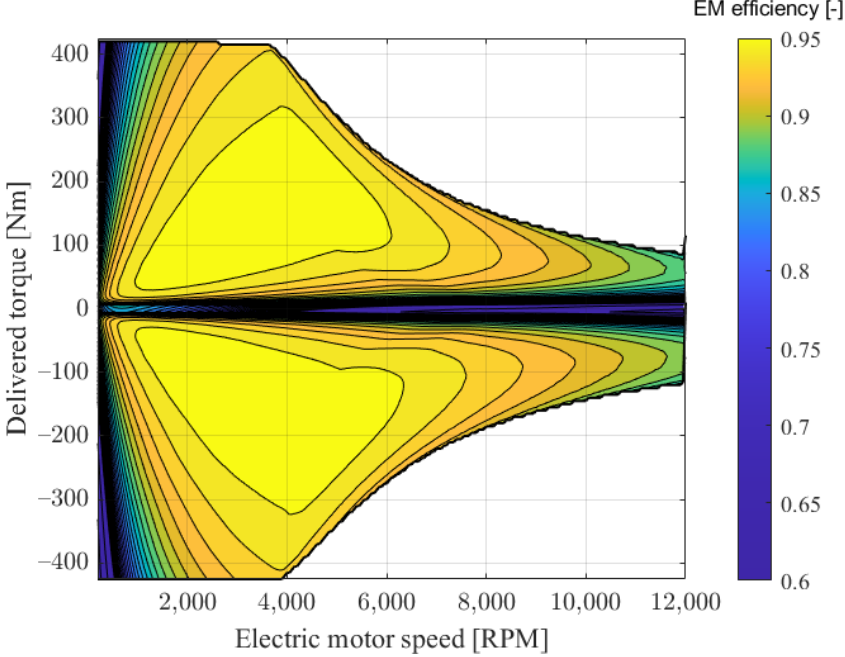
Figure 6. Electric motors efficiency